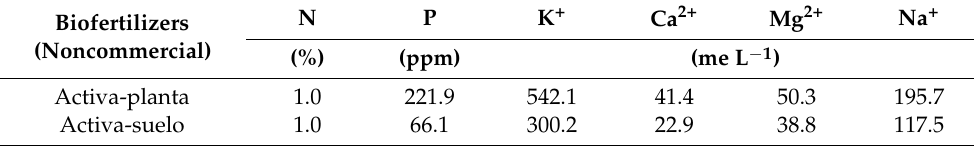
Table 6. The chemical concentration of the Activa-Planta and Activa-Suelo biofertilizers.